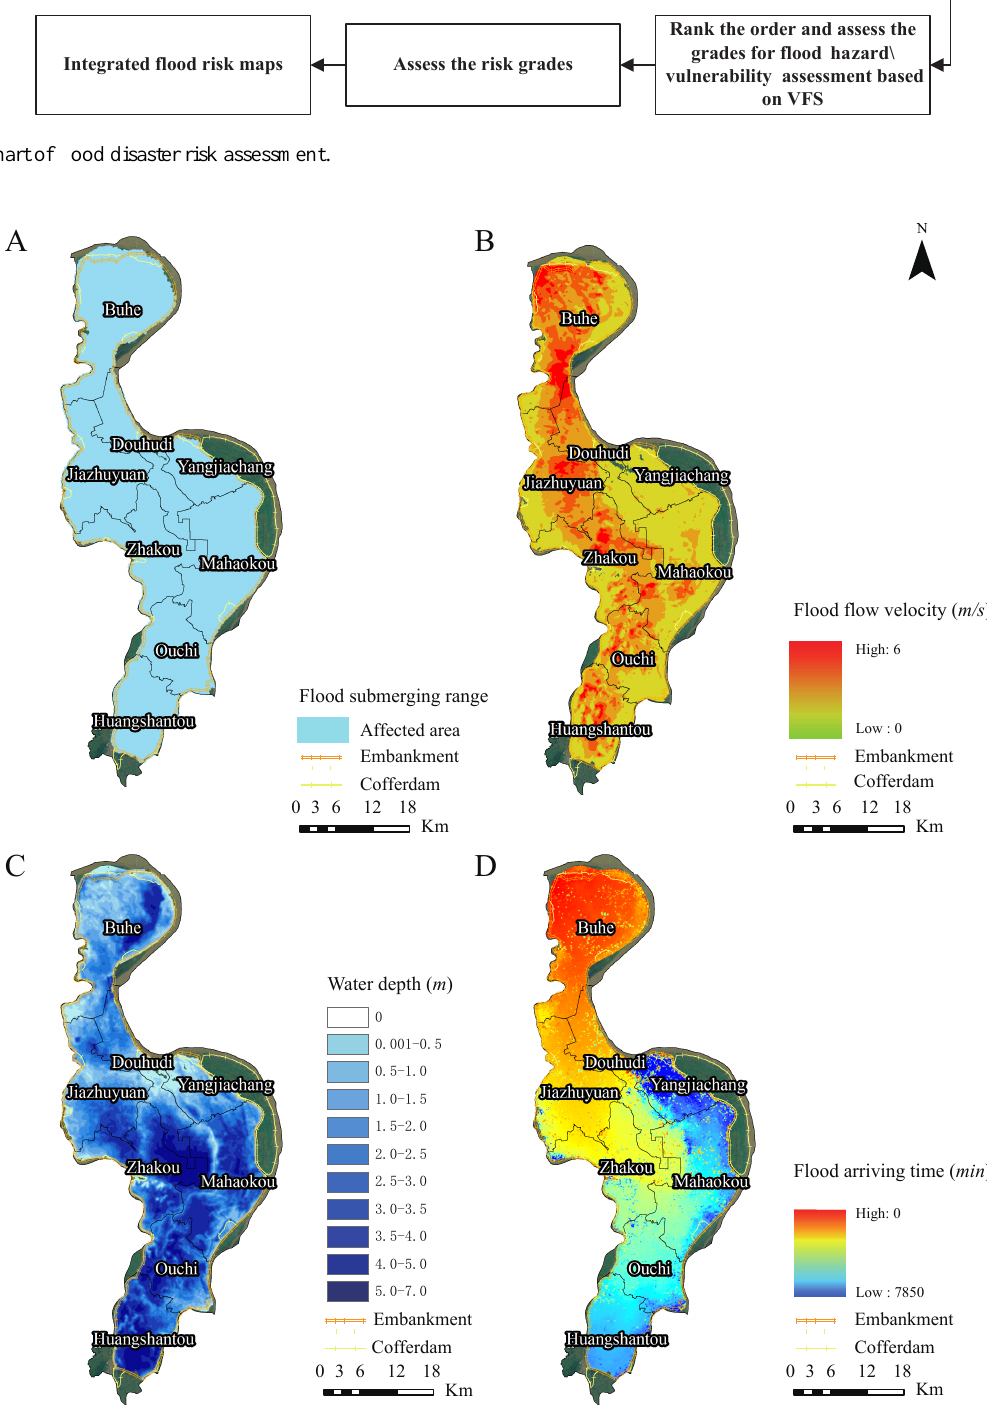
Fig. 10. Four hazard assessment indexes characteristic values from the simulation results of hydrodynamic models: (A) flood submerging range; (B) flood flow velocity; (C) flood water depth; (D) flood arriving